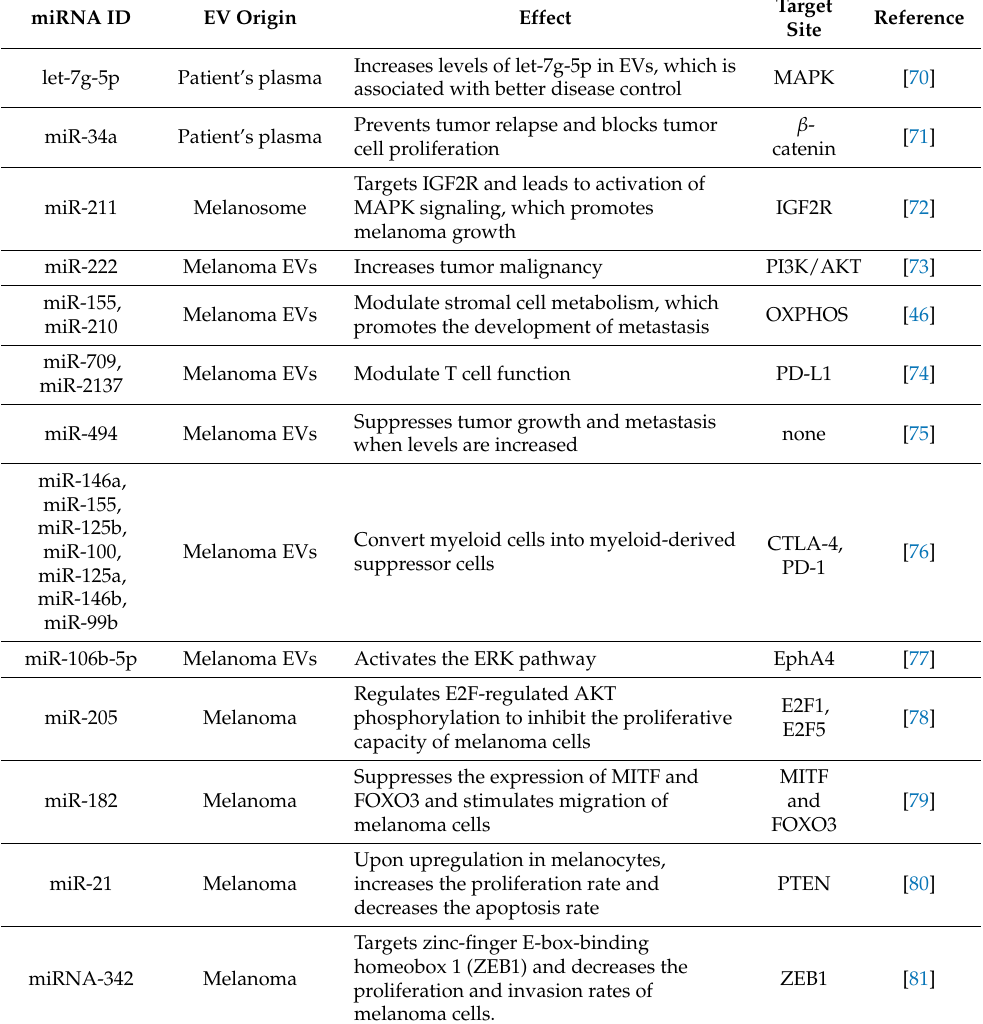
Table 4. The mechanisms and target locations of microRNA in